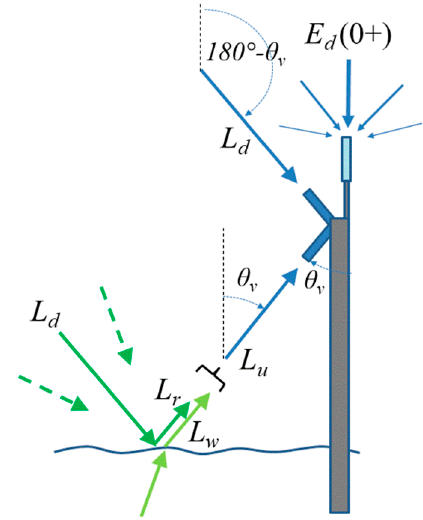
Figure 5. Schematic of above-water radiometry with measurement of sky radiance, L d , and removal of skyglint radiance, L r . Dashed arrows indicate that contributions to the skylight reflected at the air–water interface come from directions that are not directly measured by the L d radiance sensor, including possible contributions from the direct sunglint direction.